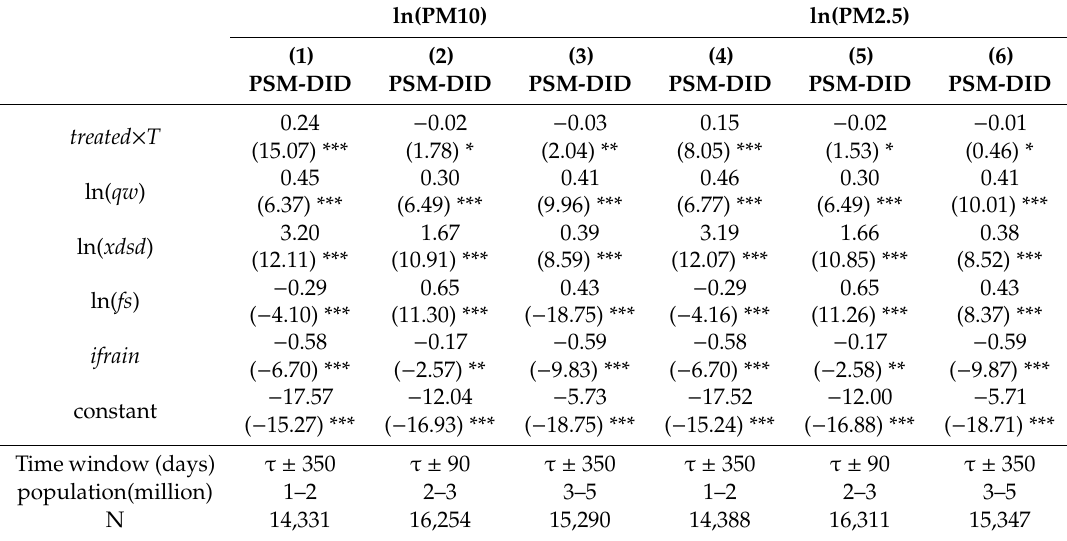
Table 7. PSM-DID estimates with varying population